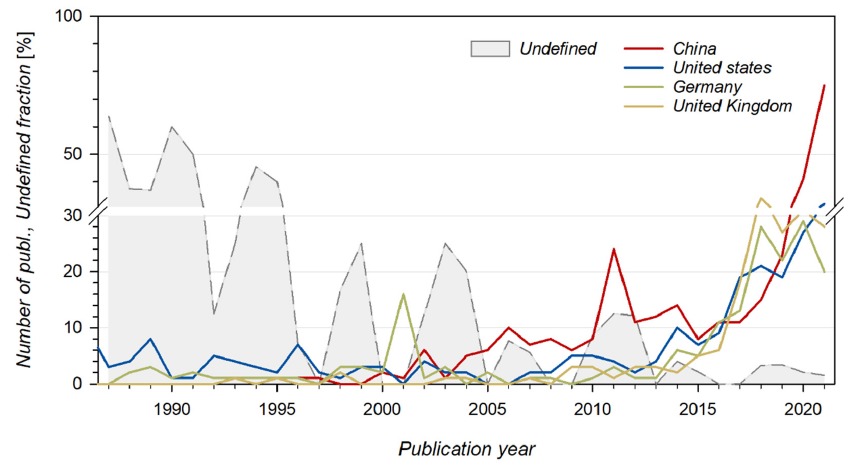
Figure 3. Annual number of publications for the four major contributing countries for 1987 to 2021. The fraction of papers with undefined affiliation is also indicated. Note the break in the y-axis.